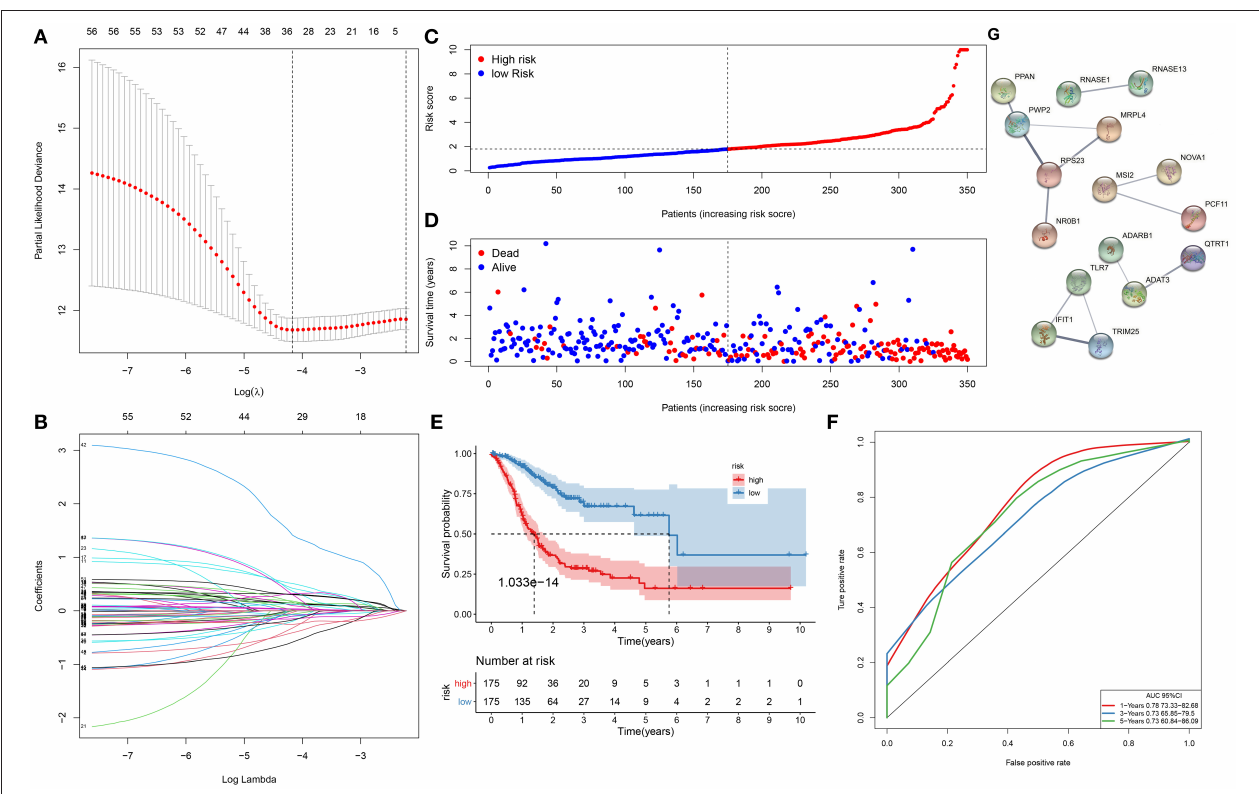
FIGURE 1 | A gene signature for predicting the survival of gastric cancer patients. (A) The optimal parameter ( λ ) is where the vertical dotted line is. (B) Regression coefficients for RNA-binding proteins (RBPs) when determining the optimal parameter ( λ ). Each curve represents the change in trajectory of coefficients for each independent variable, and the ordinate indicates the coefficient values. (C) The distribution of risk scores for all subjects. The vertical dotted line corresponds to the median value of risk scores. (D) Survival status for all subjects ranked by risk scores. (E) Kaplan–Meier curves of overall survival between high- and low-risk subjects. (F) Receiver operating characteristic curves (ROCs) of 1-, 3-, and 5-year survival. (G) A protein–protein interaction (PPI) network based on the 33 key RBP genes.